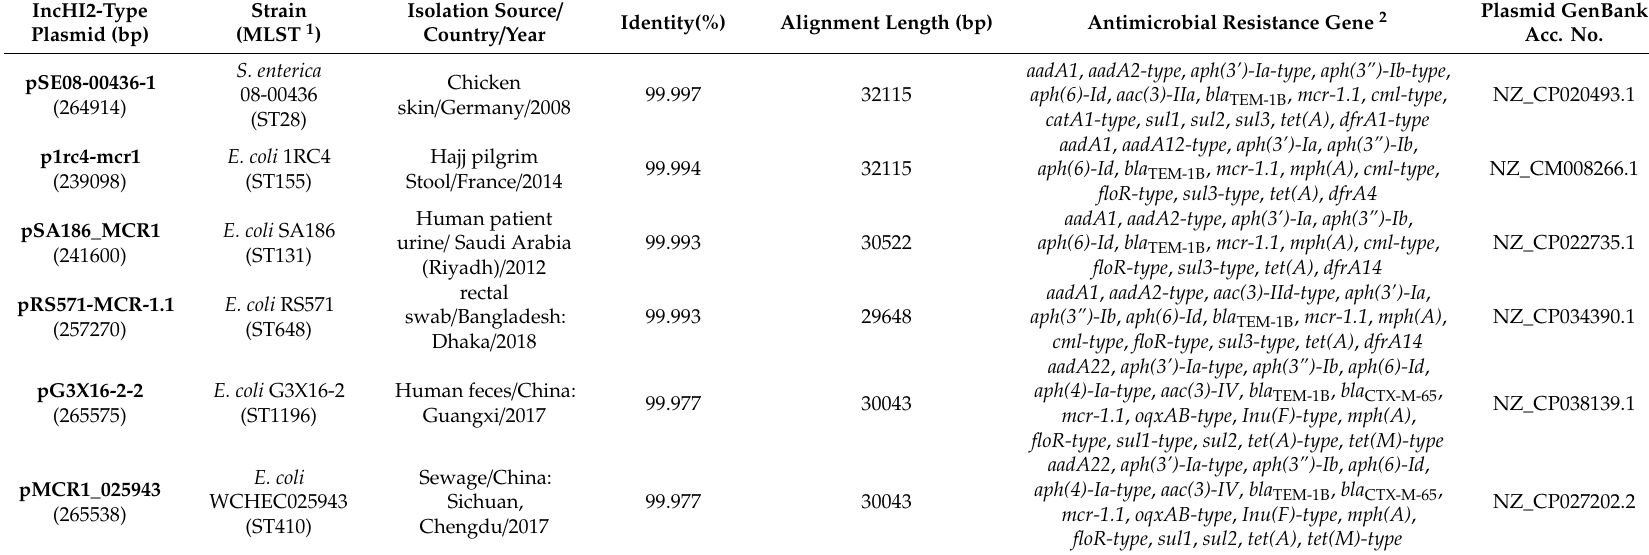
Table 1. Comparison of mcr-1.1 -harboring INSali25 contig with the top six IncHI2-type mcr-1 -harboring plasmids showing the highest identities ( > 99.6%, E -value 0.0, query coverage >